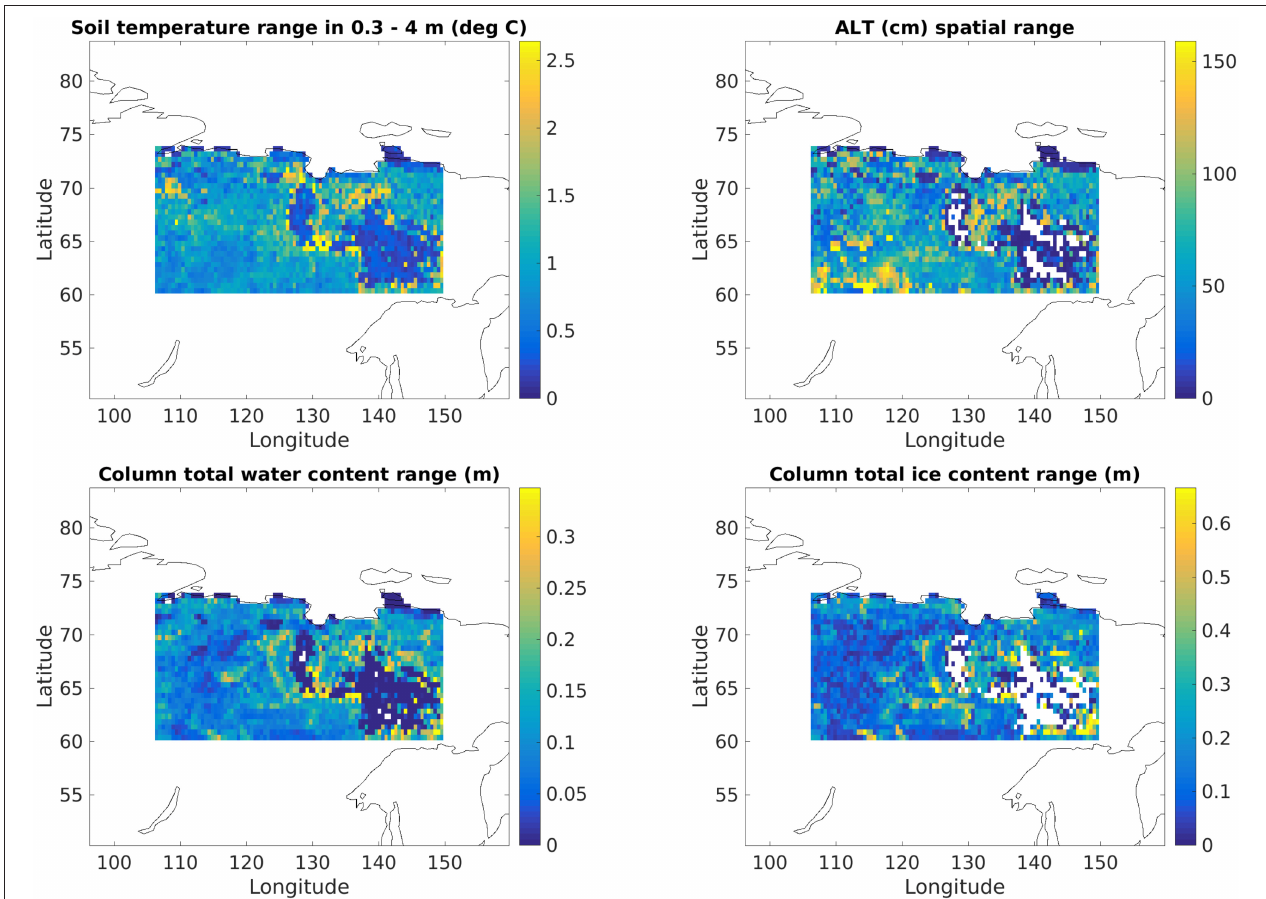
FIGURE 2 | Simulated sub-grid range of key soil state variables at 0.5 ◦ pixel size in Yakutia, East Siberia averaged during 1990–2010. The ranges are a result of only vertical processes acting on a sub-grid normal distribution of soil hydrological and thermal properties, thereby representing initial heterogeneity of soil states which will drive lateral processes increasing further heterogeneity. Subsoil temperature represents a vertical average at 0.3–4 m in order to be most comparable with observation-based results of permafrost temperature presented in Beer et al. (2013).